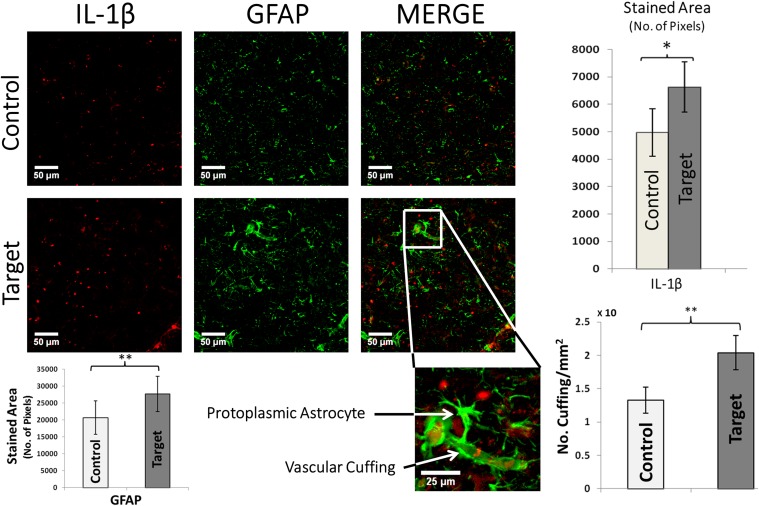
IL-1β and GFAP double immunofluorescence. Graphs (top-right) show the overall stained area of IL-1β expression in target and control areas, which indicate an undergoing inflammation in target areas. Scale bars: 50 μm. Values represented as mean ± SD (N = 8). Significant difference referred as: ∗P < 0.05 (Wilcoxson’s Signed Rank test). A typical enlarged protoplasmic astrocyte with end-feet attached to a micro-vessel forming frequent perivascular cuffing is shown in target area. Scale bars: 25 μm. Graphs (bottom-right) showing the density of perivascular cuffings in target and control areas. Values represented as mean ± SD (N = 8). Significant difference referred as: ∗∗P < 0.01 (Paired t-test). GFAP overexpression was quantified by computing the overall stained area of glial processes (p-value < 0.01, Paired t-test, bottom-left). These representative images were taken covering layers II-IV.